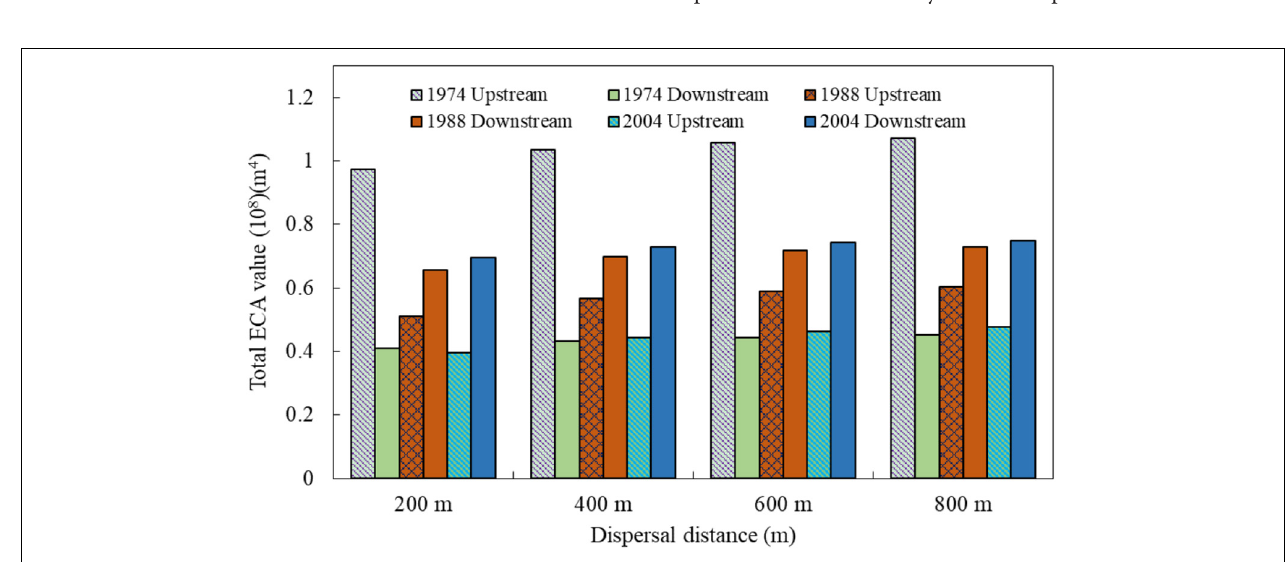
Frontiers in Ecology and Evolution |